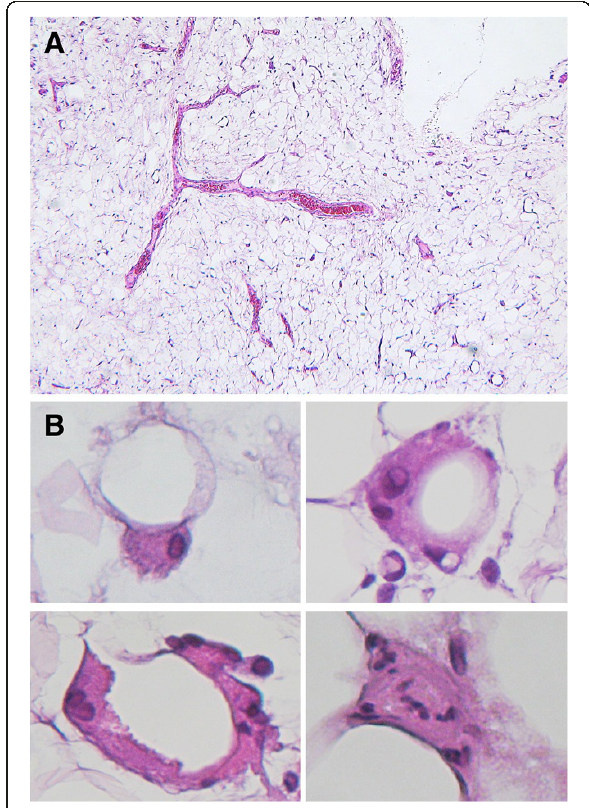
Figure 2 Malignant transformation of axillary lipomatous masses in Madelung ’ s disease. A ) At low magnification vascular density was evident with abundance of vessels with characteristic arborizing shapes (H&E; original magnification: 200x). B ) Lipoblasts were frequently observed at high power magnification (insets), together with the typical delicate vascular network (not shown). In the lower right inset an atypical mitosis is shown. These findings indicated a well differentiated liposarcoma (H&E; original magnification: